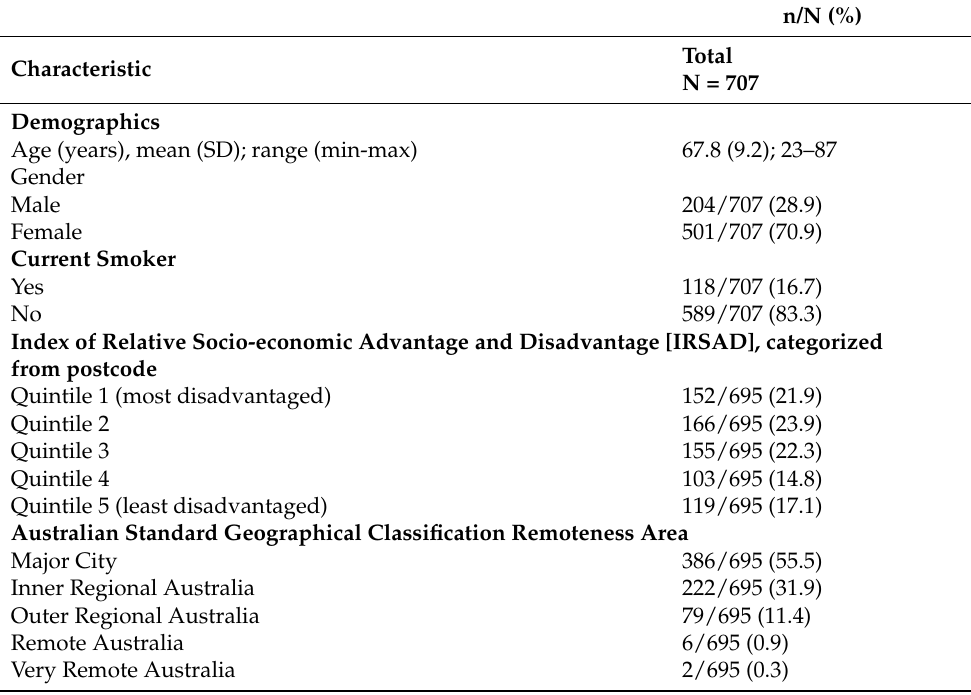
Table 1. Baseline participant